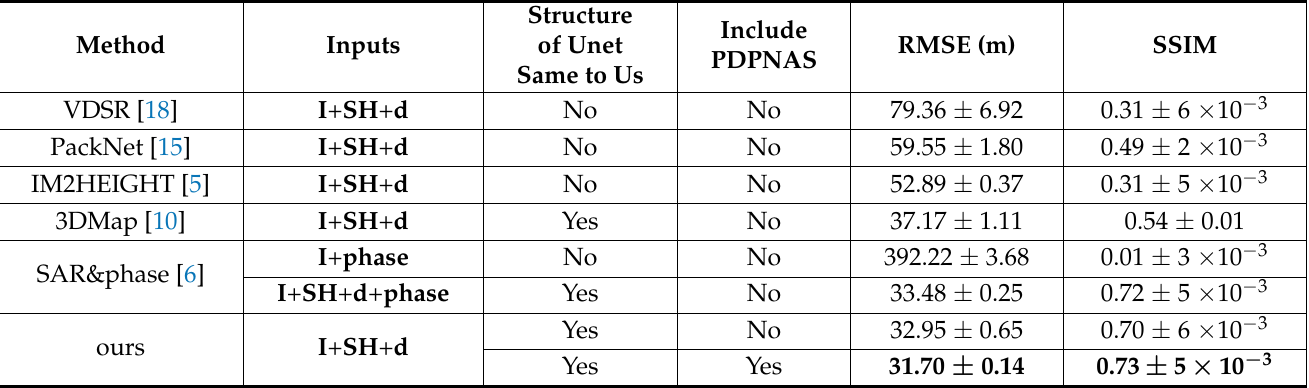
Table 3. Comparison experiments between different methods in Guiyang datasets. The sparse factors of SH are 96 ×